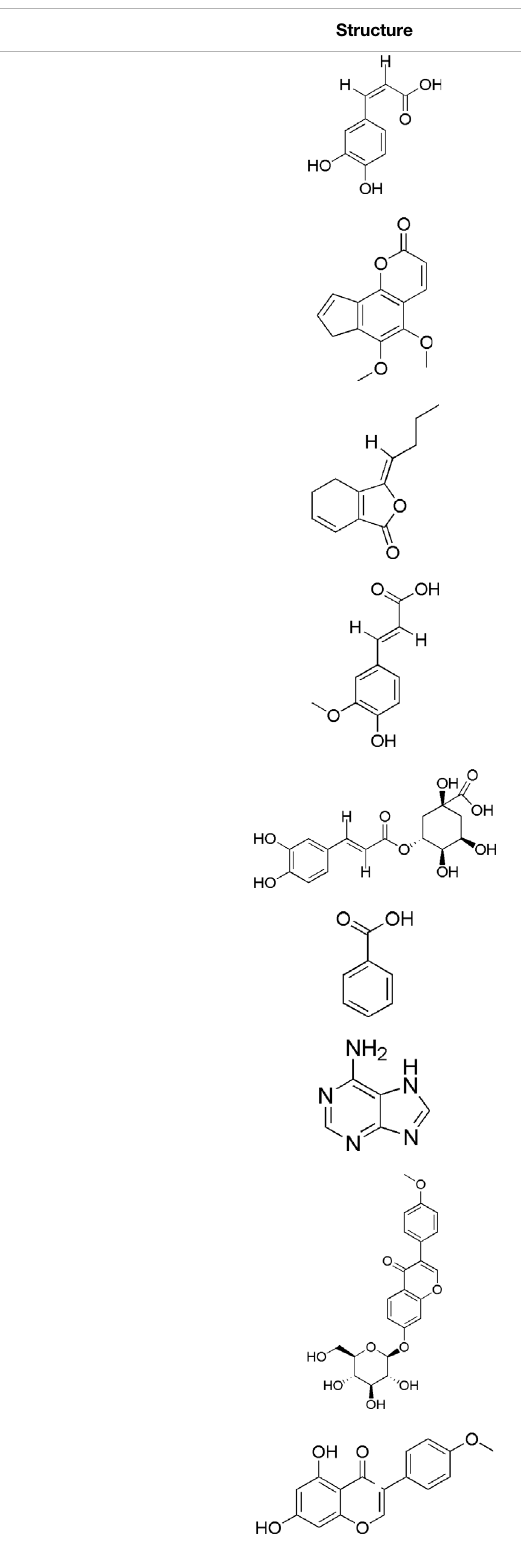
TABLE 2 | Active compounds of the Buxue Tongluo